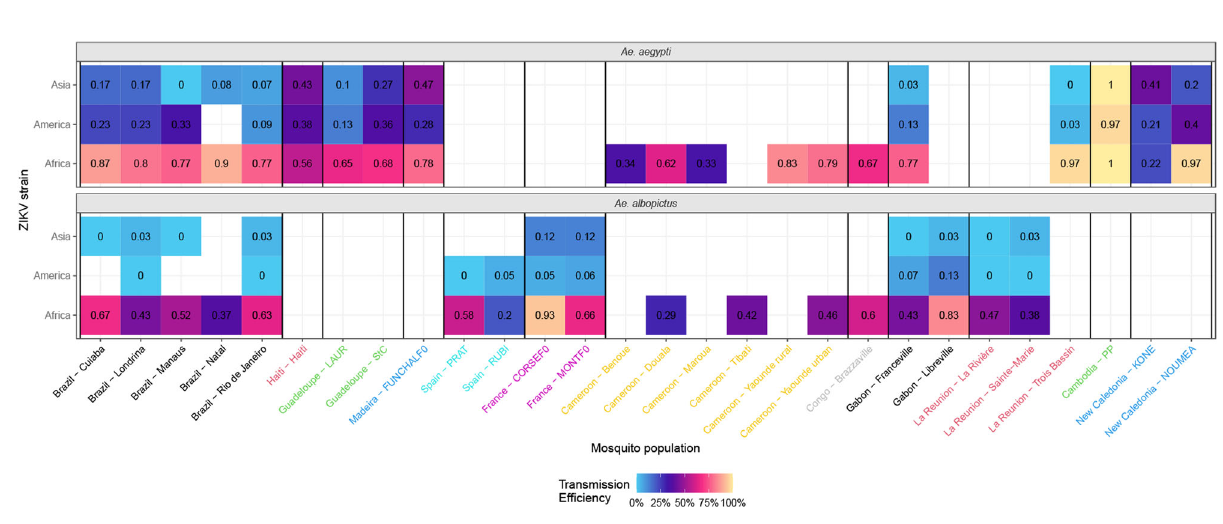
Fig. 3 | Transmission ef fi ciencies of ZIKV strains at the regional level for Ae. aegypti and Ae. albopictus mosquitoes sampled at one or more locations in every studied country, at 21 dpi. ZIKV strains were pooled in a